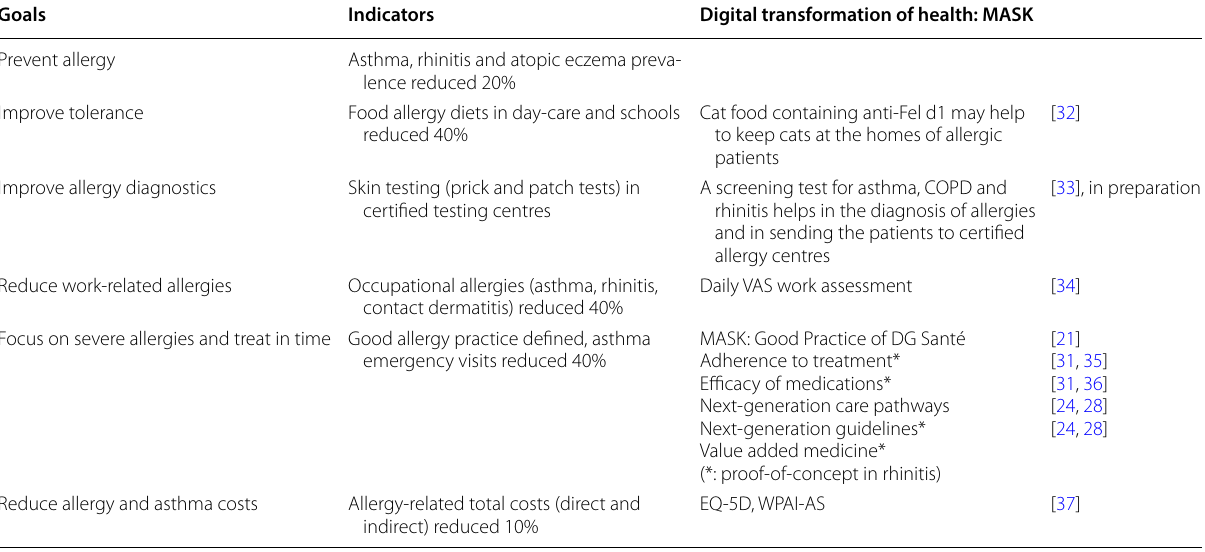
Table 2 Set‑up goals for health care of the Finnish Allergy Programme and digital health